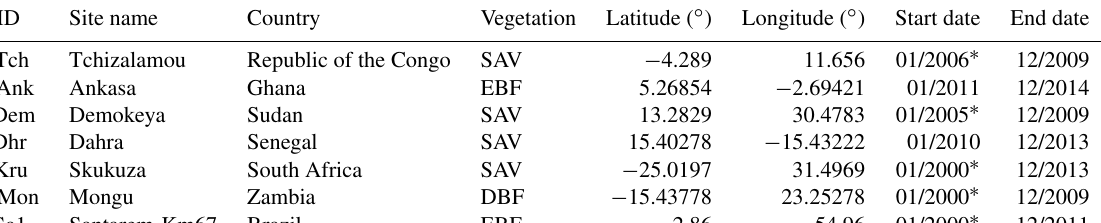
Table 1. Information on flux tower sites in Africa and Brazil. The symbol “*” indicates that flux observations before 2007 were not used in this study. The major biomes are savanna (SAV), evergreen broadleaf forest (EBF), and deciduous broadleaf forest (DBF). The distribution of the towers over Africa is indicated in Fig. 1e. Note that we also included the details of one tower outside of Africa, BR-Sa1, that was used for our analysis of tropical evergreen broadleaf forests. Start and ends dates are given in the format month/year.